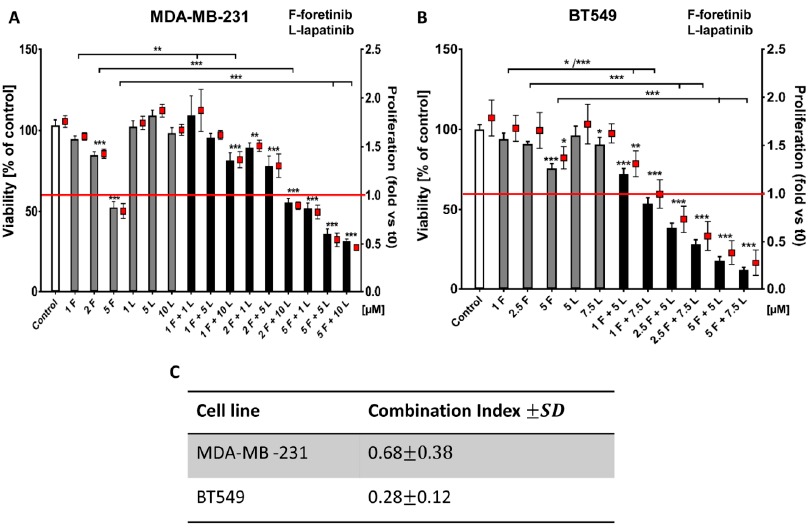
Figure 1. The effects of foretinib, lapatinib, and their combination on TNBC cell line viability and proliferation were measured using XTT assay (see the methods section). Cells were seeded on a layer of polymerized collagen. EGF and HGF was present in all conditions. Viability and proliferation of ( A ) MDA-MB-231 cells and ( B ) BT549 cells after 24 h of incubation with the indicated concentrations of inhibitors (in µM) were compared to those of control cells (percentage of viable cells versus control with a control set to 100 or proliferation-based fold change versus control). Results expressed as the mean ± SD are based on at least three independent experiments. The statistical significance was assessed versus that of the control. The significance level was set at p ≤ 0.05 (*), p ≤ 0.01 (**), or p ≤ 0.001 (***). ( C ) The combination index (CI) after 24 h of drug treatment was determined. Drug combinations in which CIs were <1.0 were considered as synergistic.